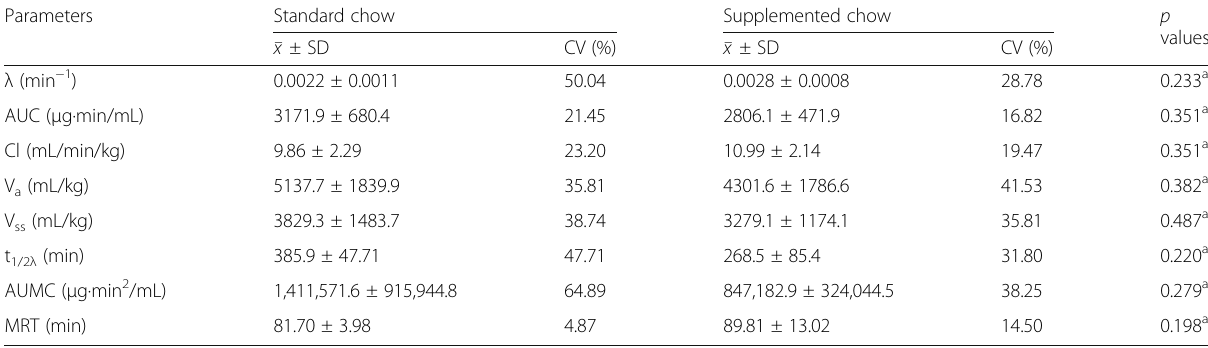
Table 1 Non-compartmental pharmacokinetic parameters obtained for metformin after its intravenous administration (30 mg/kg) to diabetic rabbits ( n = 6) Parameters